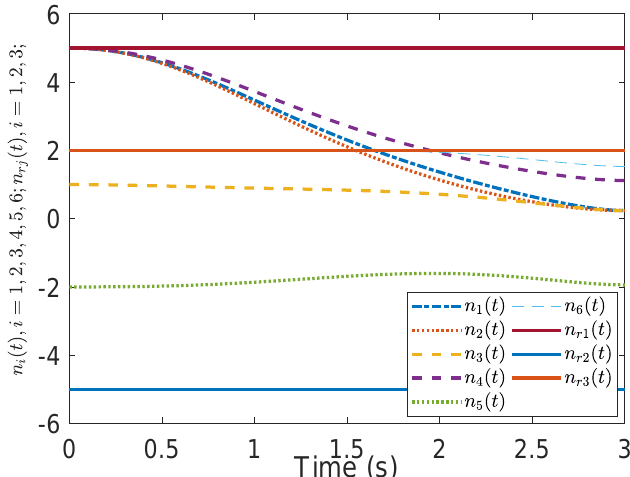
Figure 6. Position states n (t) by the prescribed-time Controller (62).